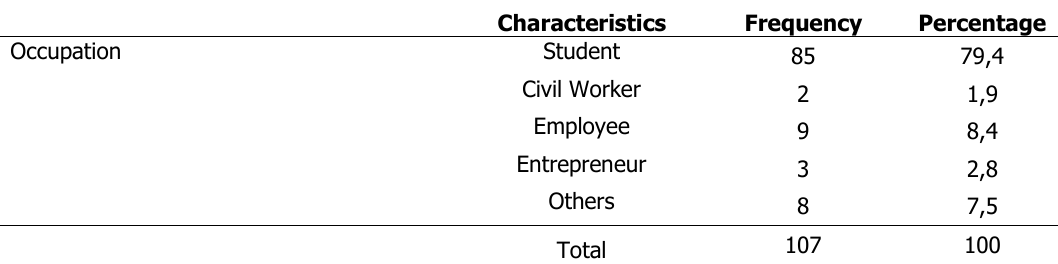
Table 3. Demographic Characteristics of Observations Based on